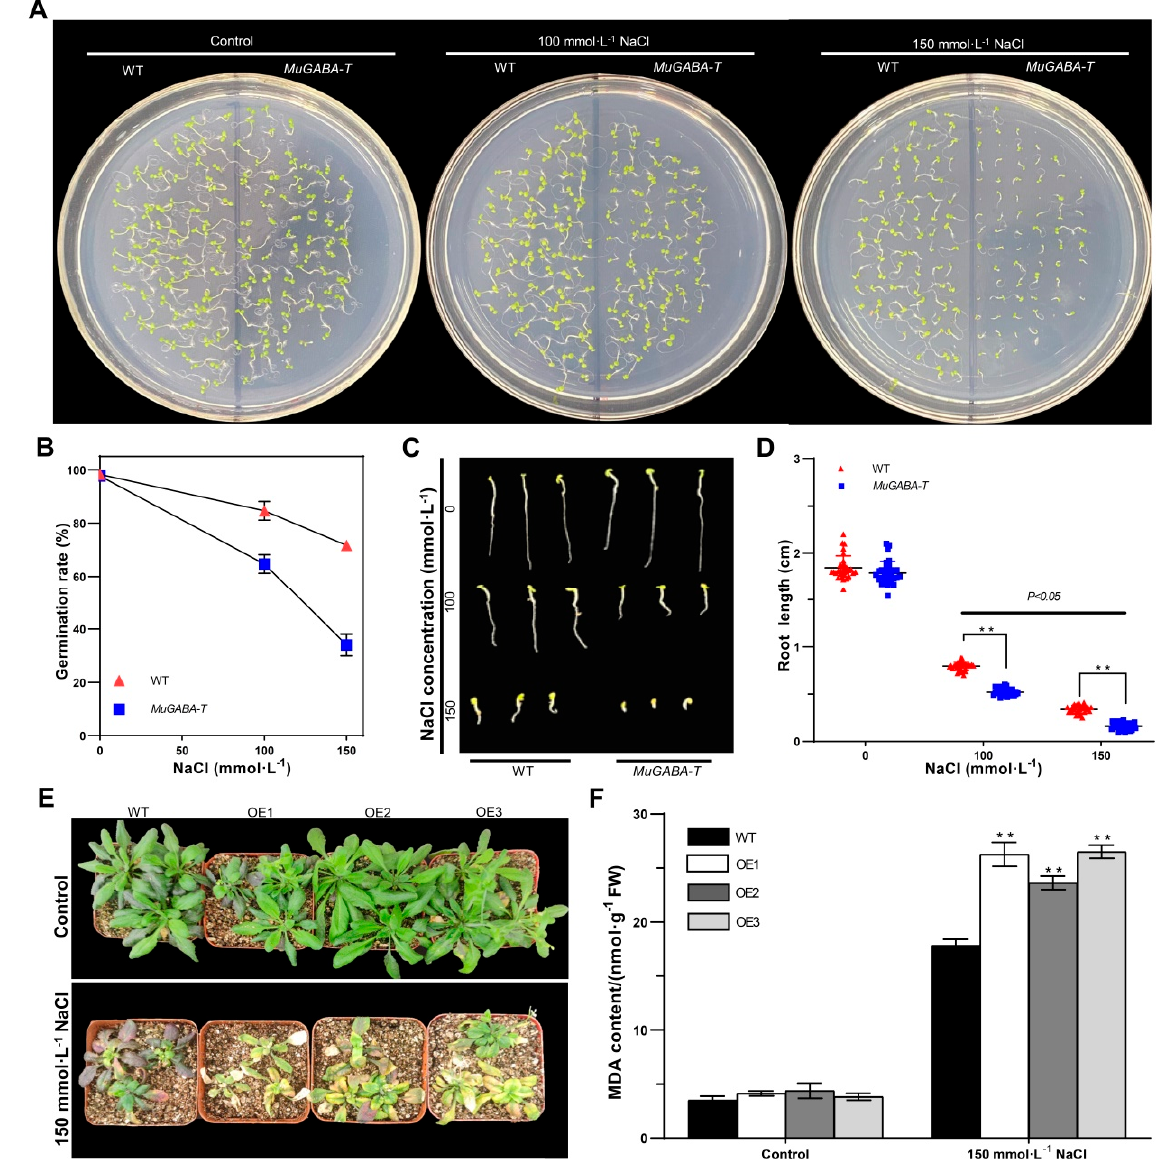
Figure 5. Phenotypic and physiological characterization of transgenic MuGABAT Arabidopsis upon NaCl treatment. Effects of NaCl stress on the germination ( A , B ), and root length ( C , D ) of WT and transgenic MuGABA-T Arabidopsis . Seeds were grown in Petri dishes for 7 d in 1/2 MS medium with 100 or 150 mmol · L − 1 NaCl. Data are mean ± SD (n = 6), and the double asterisks indicate significant differences at p < 0.05. Effects of salt stress on morphology ( E ) and MDA content ( F ) of Arabidopsis seedlings. All the 4-week-old seedlings were grown in pots under control conditions, followed by salt stress treatment. Data are mean ± SD (n = 6), and the double asterisks indicate significant differences at p < 0.05.